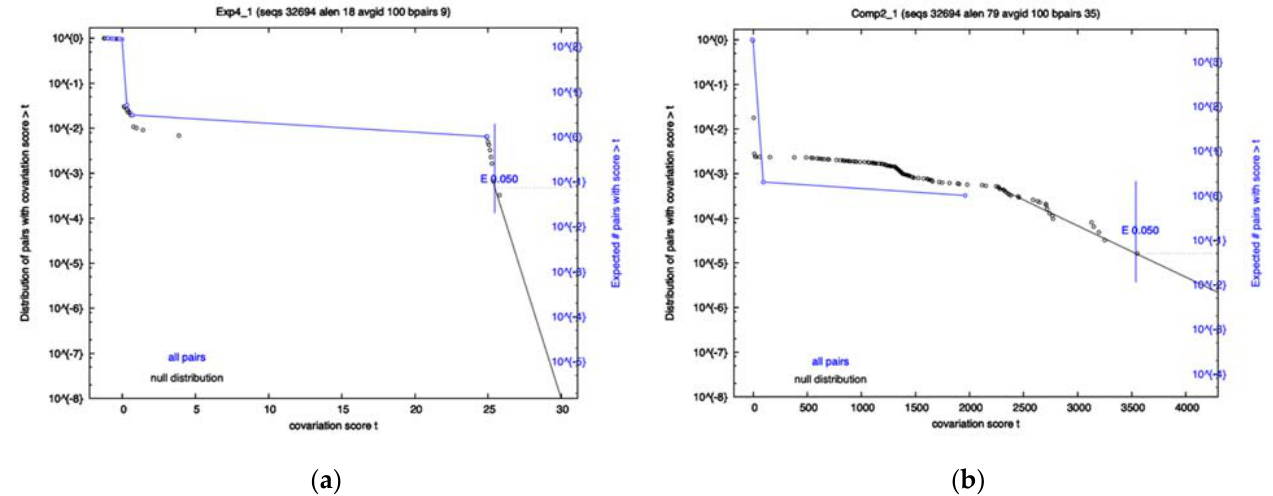
Figure 1. Survival Plots of two of the 8 RRI candidate regions. Each plot has two lines: Black indicates a null distribution; Blue is all base pairs in the interaction. Exp4 is shown on Panel ( a ), with Comp2 on Panel ( b ). Significance cutoff used was 0.05.